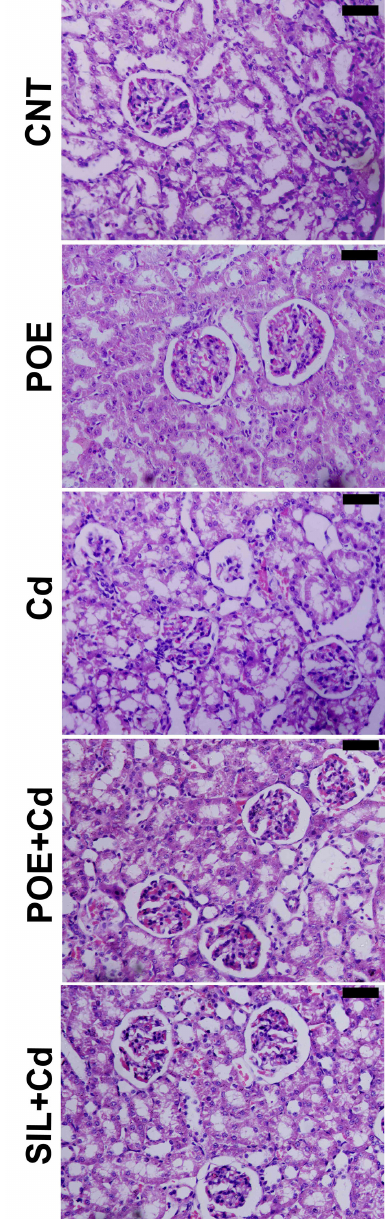
Figure 3. POE and SIL improved rat kidney damage induced by Cd. (CNT) Sections from control group with normal architecture. (POE) P. ostreatus methanolic extract inoculated group with normal structure. (Cd) Untreated Cd-intoxicated group with damaged glomeruli. (POE+Cd) Sections from P. ostreatus methanolic extract treated Cd-intoxicated female rats with improved histological structure. (SIL+Cd) Sections from silymarin-treatedCd-intoxicated rats with improved structure. Sections are stained with hematoxylin and eosin. Bar = 50